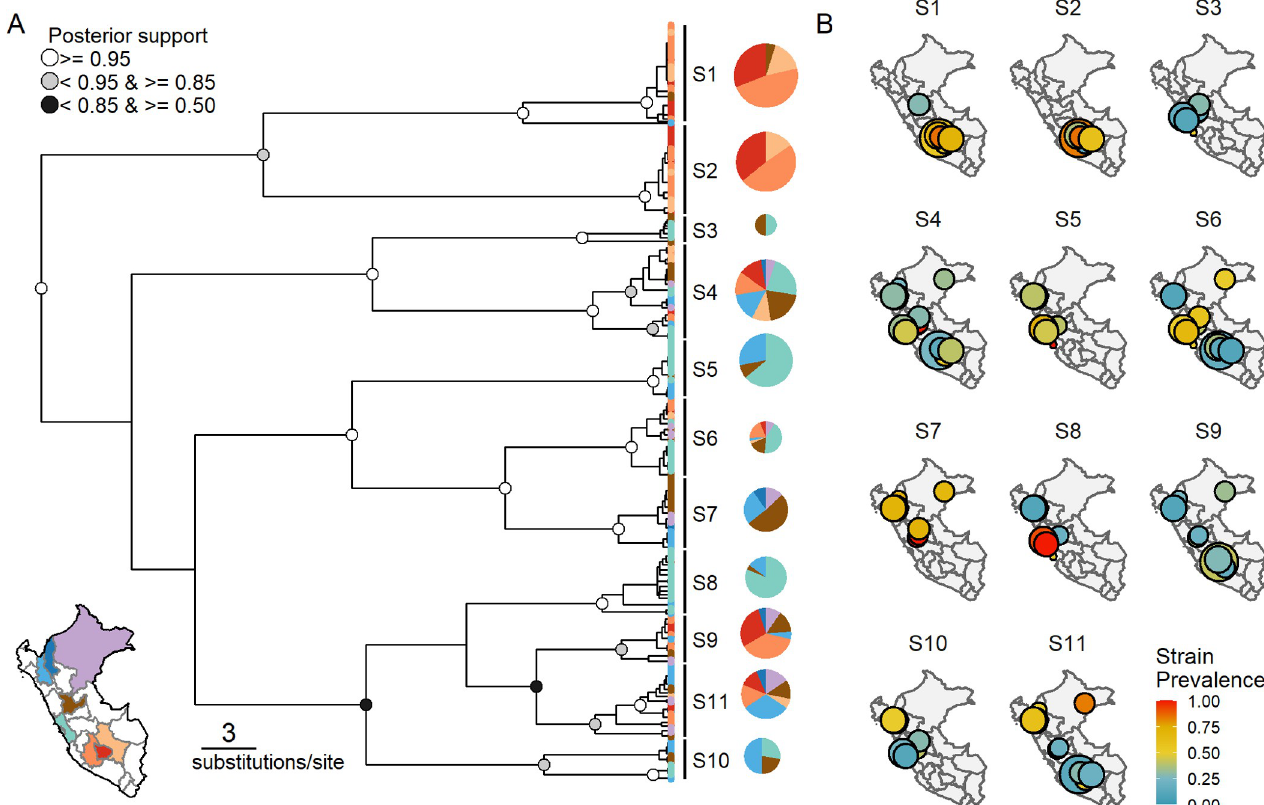
Fig 1. Distinct geographic profiles of 11 circulating strains of DrBHV. (A) Bayesian phylogeny of a 150-bp region of the UL55 glycoprotein B region of DrBHV. Tip colours and pie charts show the geographic origins of viruses within strains (see inset map). Pie chart size is proportional to the number of samples in which each strain was detected. Node colours represent posterior probability; support of < 0.5 is not shown. (B) Prevalence maps of each DrBHV strain. Each map corresponds to a single strain, numbered S1 to S11 as in panel A. Points represents all colonies within 10 km with circle size proportional to sample size (range = 2 to 14, mean = 7.82) and colour indicating prevalence of infection (base map: https://gadm.org/maps/PER.html). Data underlying this figure can be found in (A) S1 Data and (B) S2 Data. D AU : AbbreviationlistshavebeencompiledforthoseusedthroughoutFigs 1 ; 3 ; and 4 : Pleaseverifythatallentriesarecorrect : rBHV, Desmodus rotundus